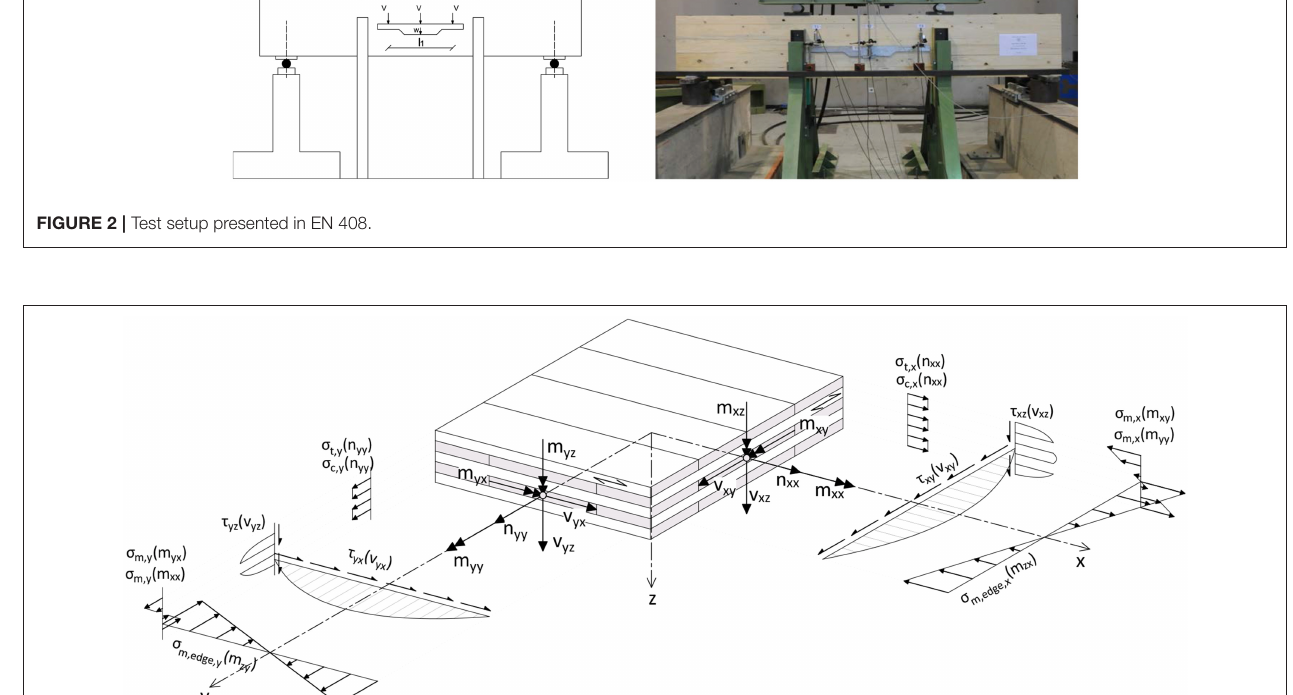
FIGURE 3 | Shear stresses, modified from COST document (Brandner et al.,